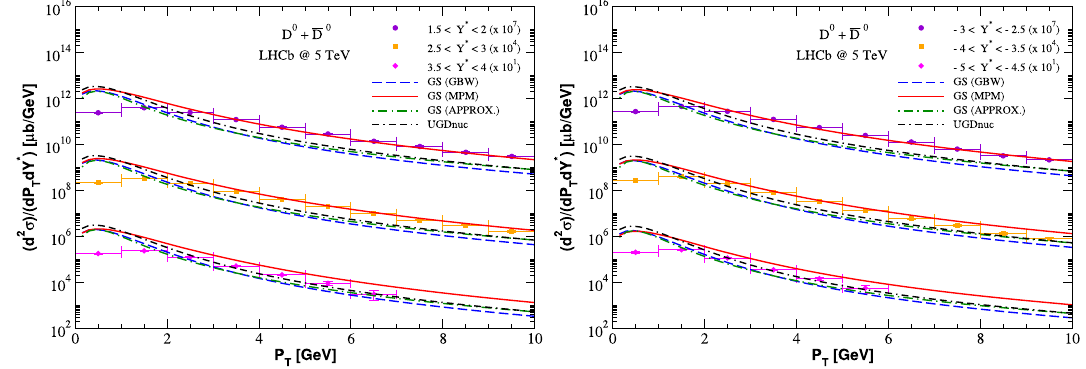
Fig. 2 The differential D 0 production cross section as a function of GS(MPM),GS(APPROX.)andUGDnucmodelsaredirectlycompared √ P T and Y in pPb collisions at s = 5 TeV considering three forward with the experimental data from the LHCb Collaboration and backward rapidity bins. The predictions given by the GS (GBW),